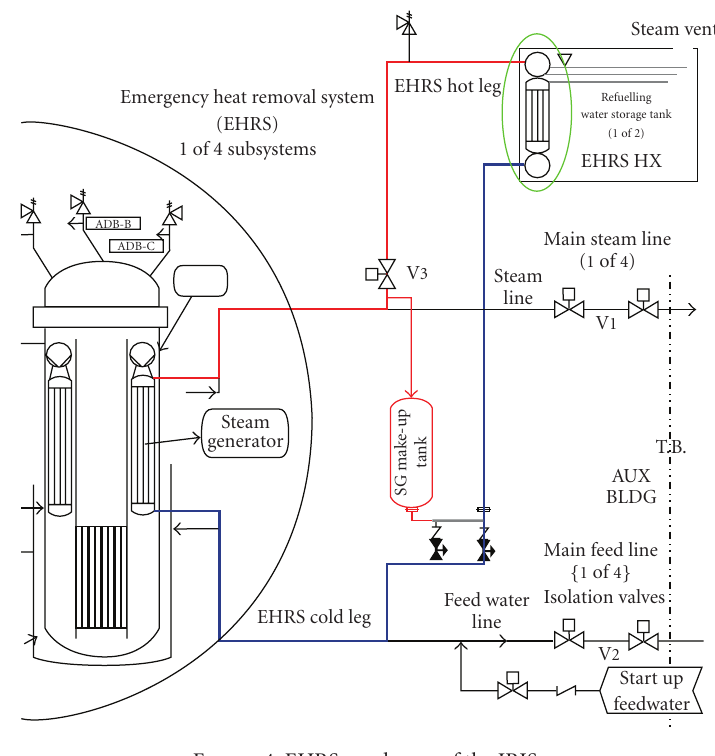
Figure 4: EHRS condenser of the IRIS.